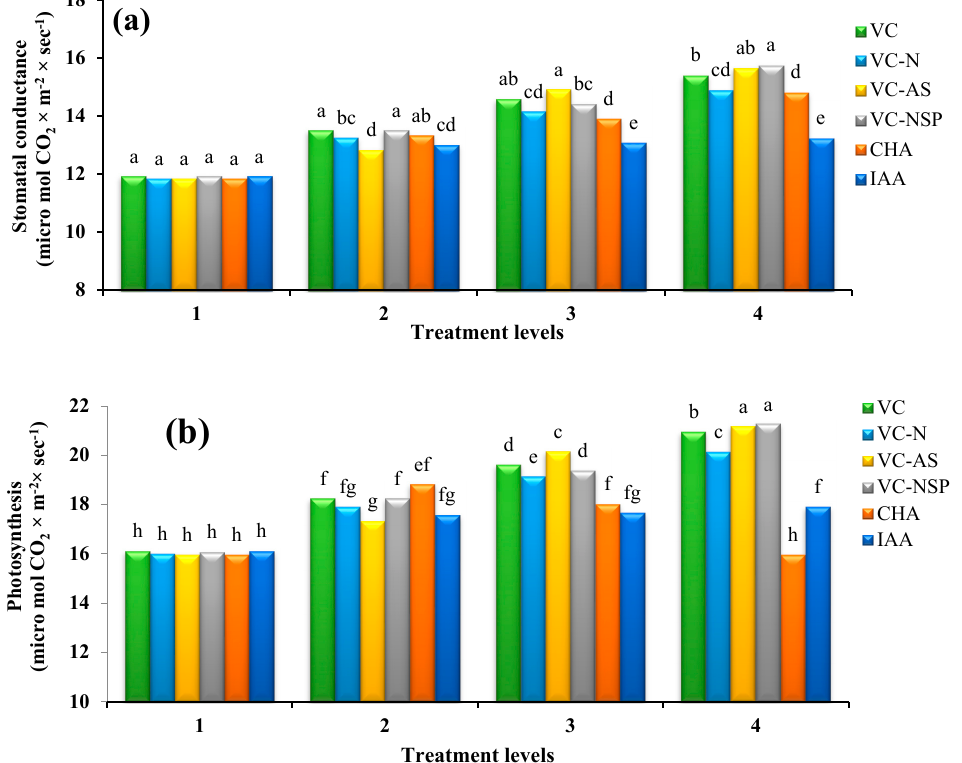
Figure 3. Comparison of average soil application of experimental treatments on stomatal conductance ( a ) and photosynthesis ( b ) at treatment levels (levels 1, 2, 3 and 4 for VC, VC-N, VC-AS and VC-NSP treatments of 0, 1, 2 and 3% VC, 0, 200, 400 and 600 mg of CHA per kg of soil and 0, 10 − 6 , 10 − 5 and 10 − 4 molar IAA). Different letters in each figure show significant difference at p ≤ 0.05 by Duncan multiple range test. VC, VC without enrichment; VC-N, VC enriched with 1% nitrogen; VC-NSP, VC enriched with 1% nitrogen, 1% sulfur, and 1% phosphorus; VC-AS, VC enriched with Azotobacter chroococcum (21Az) + Pseudomonas fluorescens (Ps 59); CHA, Commercial humic acid; IAA, Indole-3-acetic acid.